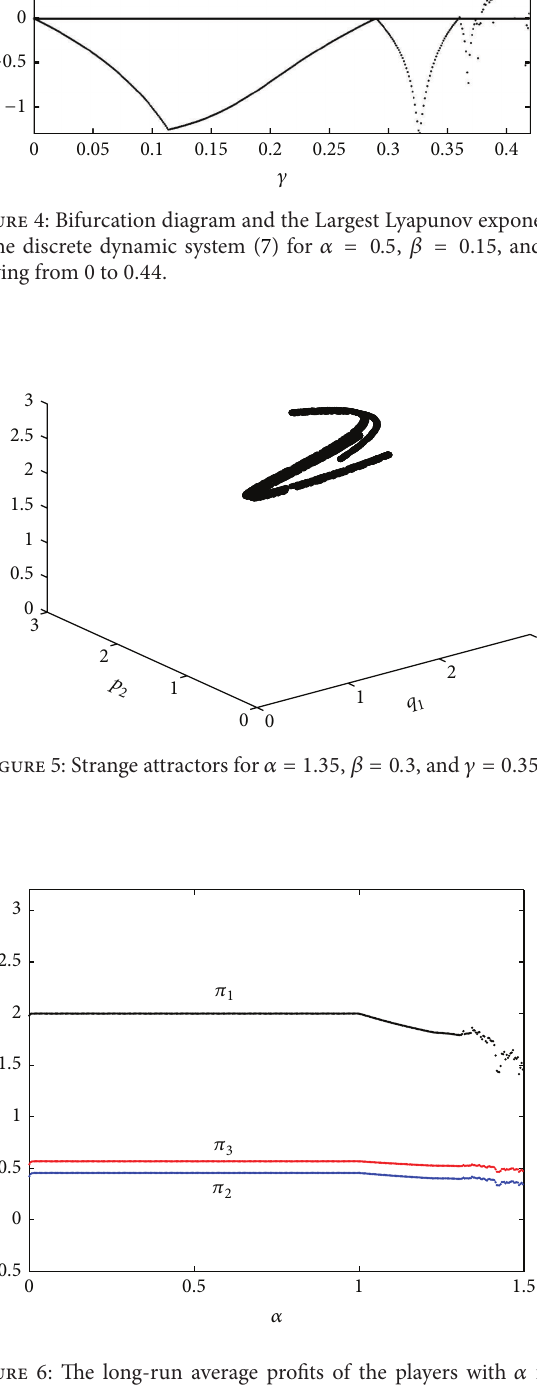
Figure 6: The long-run average profits of the players with 𝛼 for system